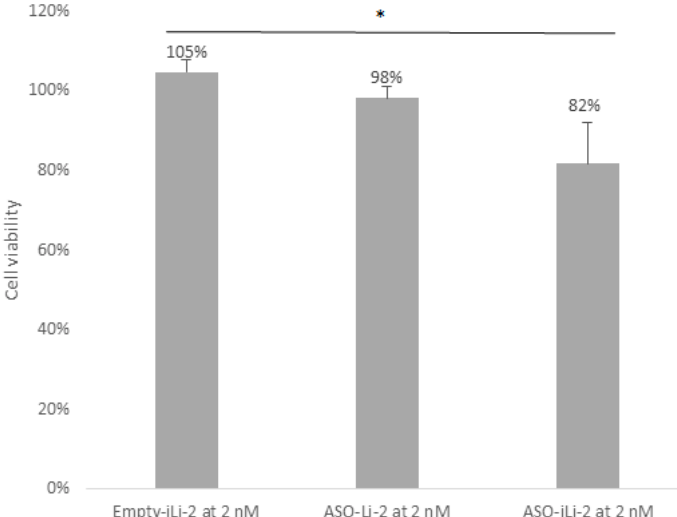
Figure 9. Cell viability (%) of 5000 PC-3 cell spheroids when exposed to Empty-iLi-2 at 2 nM, ASO-Li-2 at 2 nM and ASO-iLi-2 at 2 nM (***, 0; **, 0.001; * 0.01).